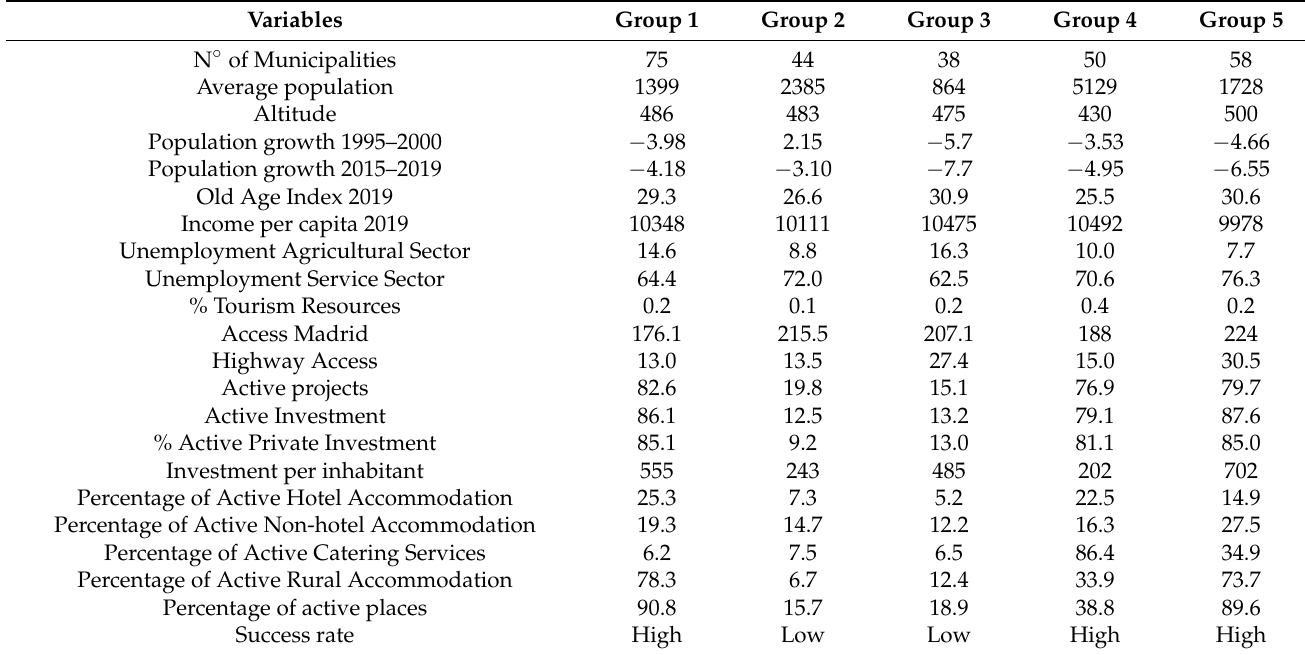
Table 7. Average data by